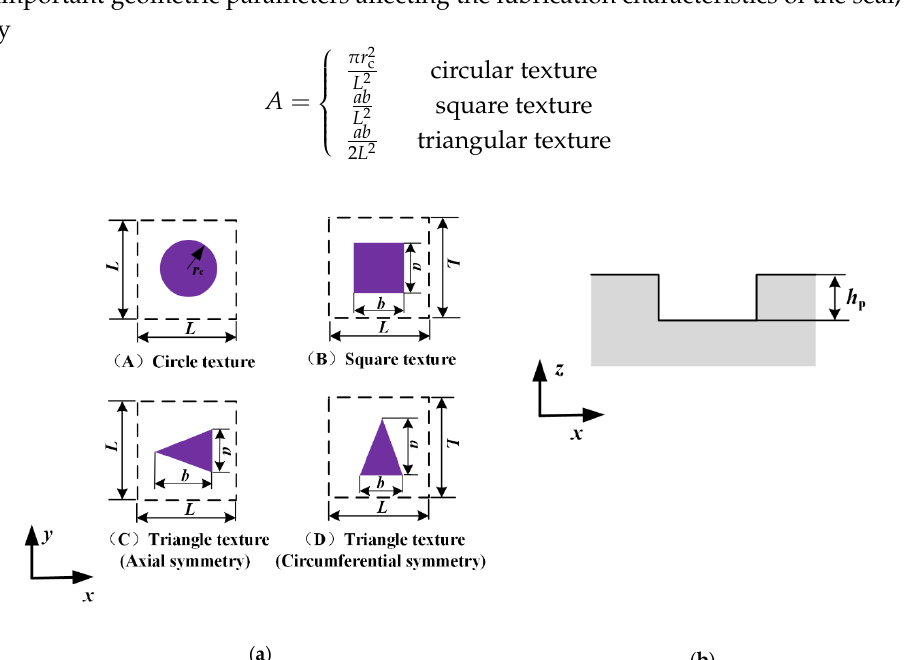
Figure 2. ( a ) Micro-cavity texture geometries and ( b ) cross-section of the texture.